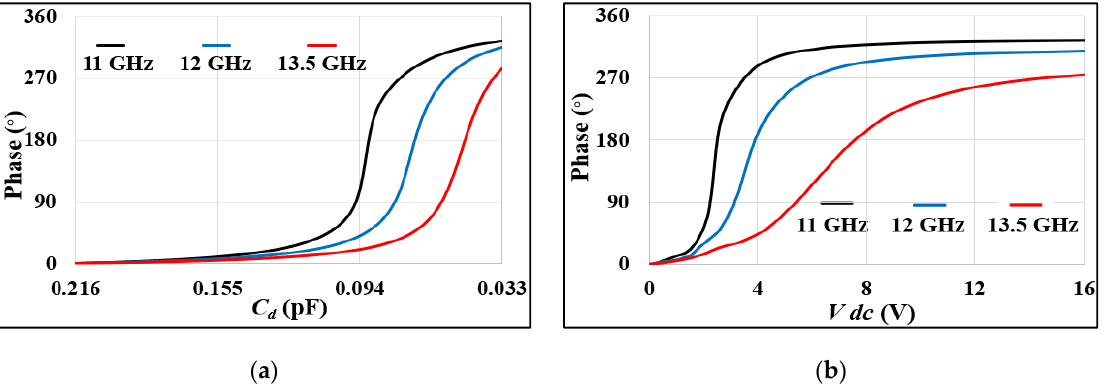
Figure 12. Calibration of the reflection phase to the varactor reverse bias for 11 GHz, 12 GHz, and13.5 GHz from left to right, respectively: ( a ) simulation reflection phase calibration results and ( b ) measurement reflection phase calibration results.